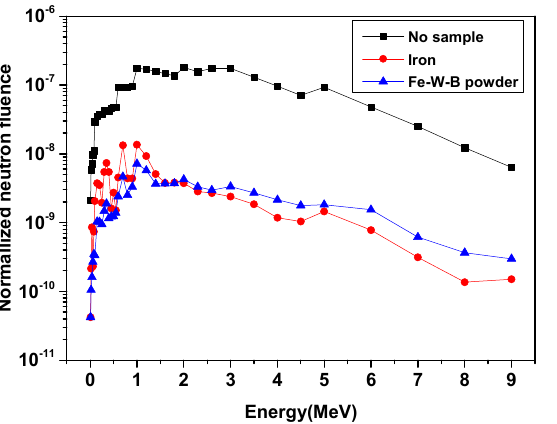
Figure 10. Neutron energy spectrum of Cf-252 source neutrons passing through Fe-W-B amorphous powder, iron and sample-free.